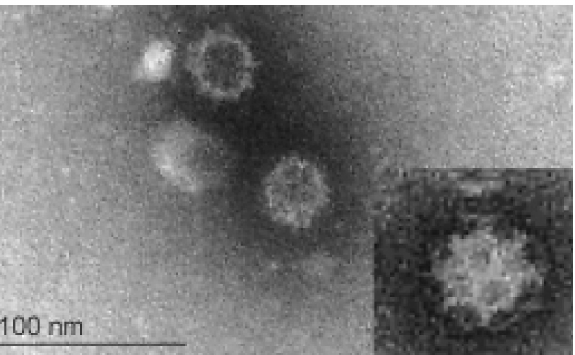
Figure 1. At high magnification, the eponymic goblets (calices) are visible on the virion surface. © Marian C.